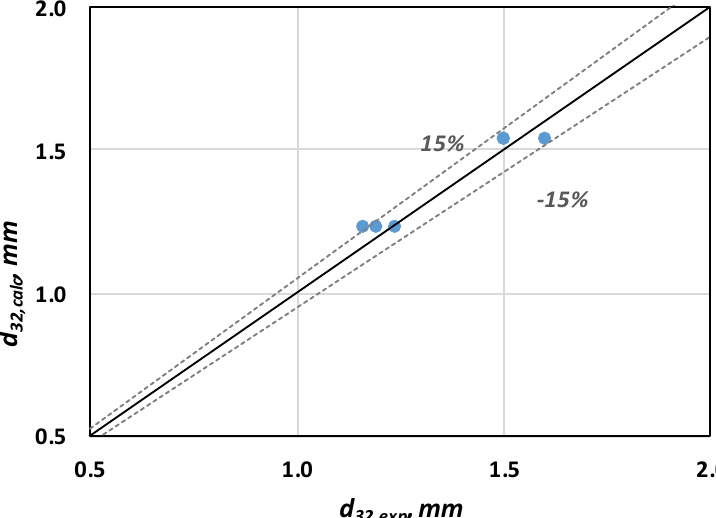
Figure 4. Comparison of the Sauter mean diameter prediction with experimental data (Table 5) ( U GS = 0.01 m/s, d p = 40 µ m, d c = 9 cm).